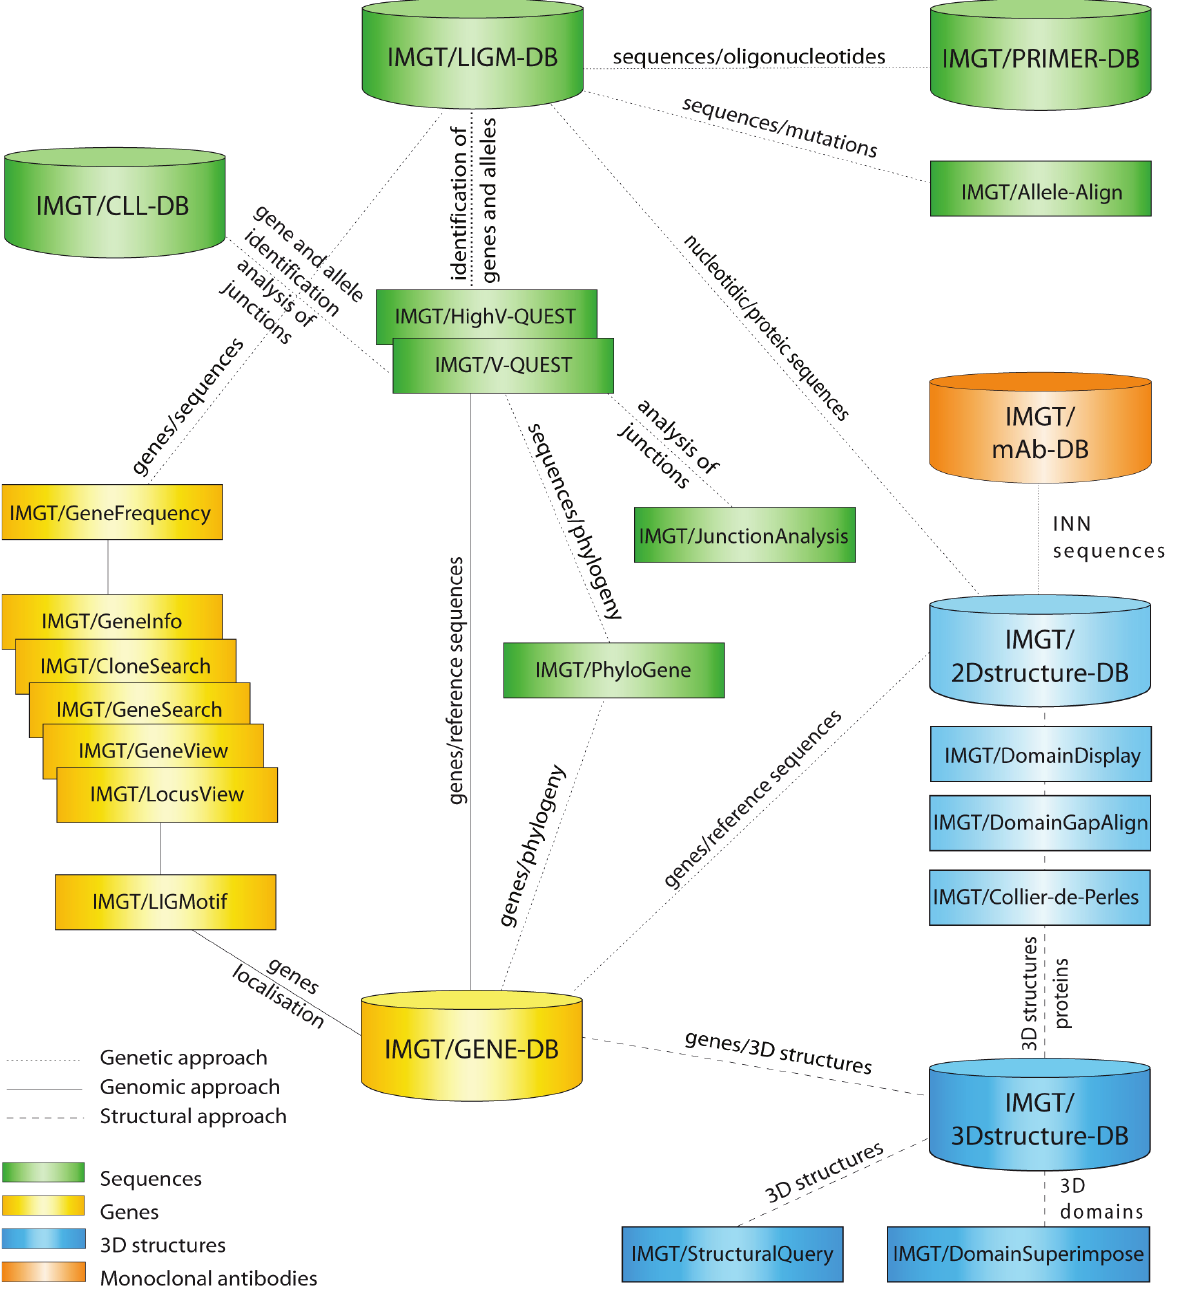
Figure 1. IMGT ® , the international ImMunoGeneTics information system ® [1,2]. Databases are shown as cylinders and tools as rectangles. The web resources are not